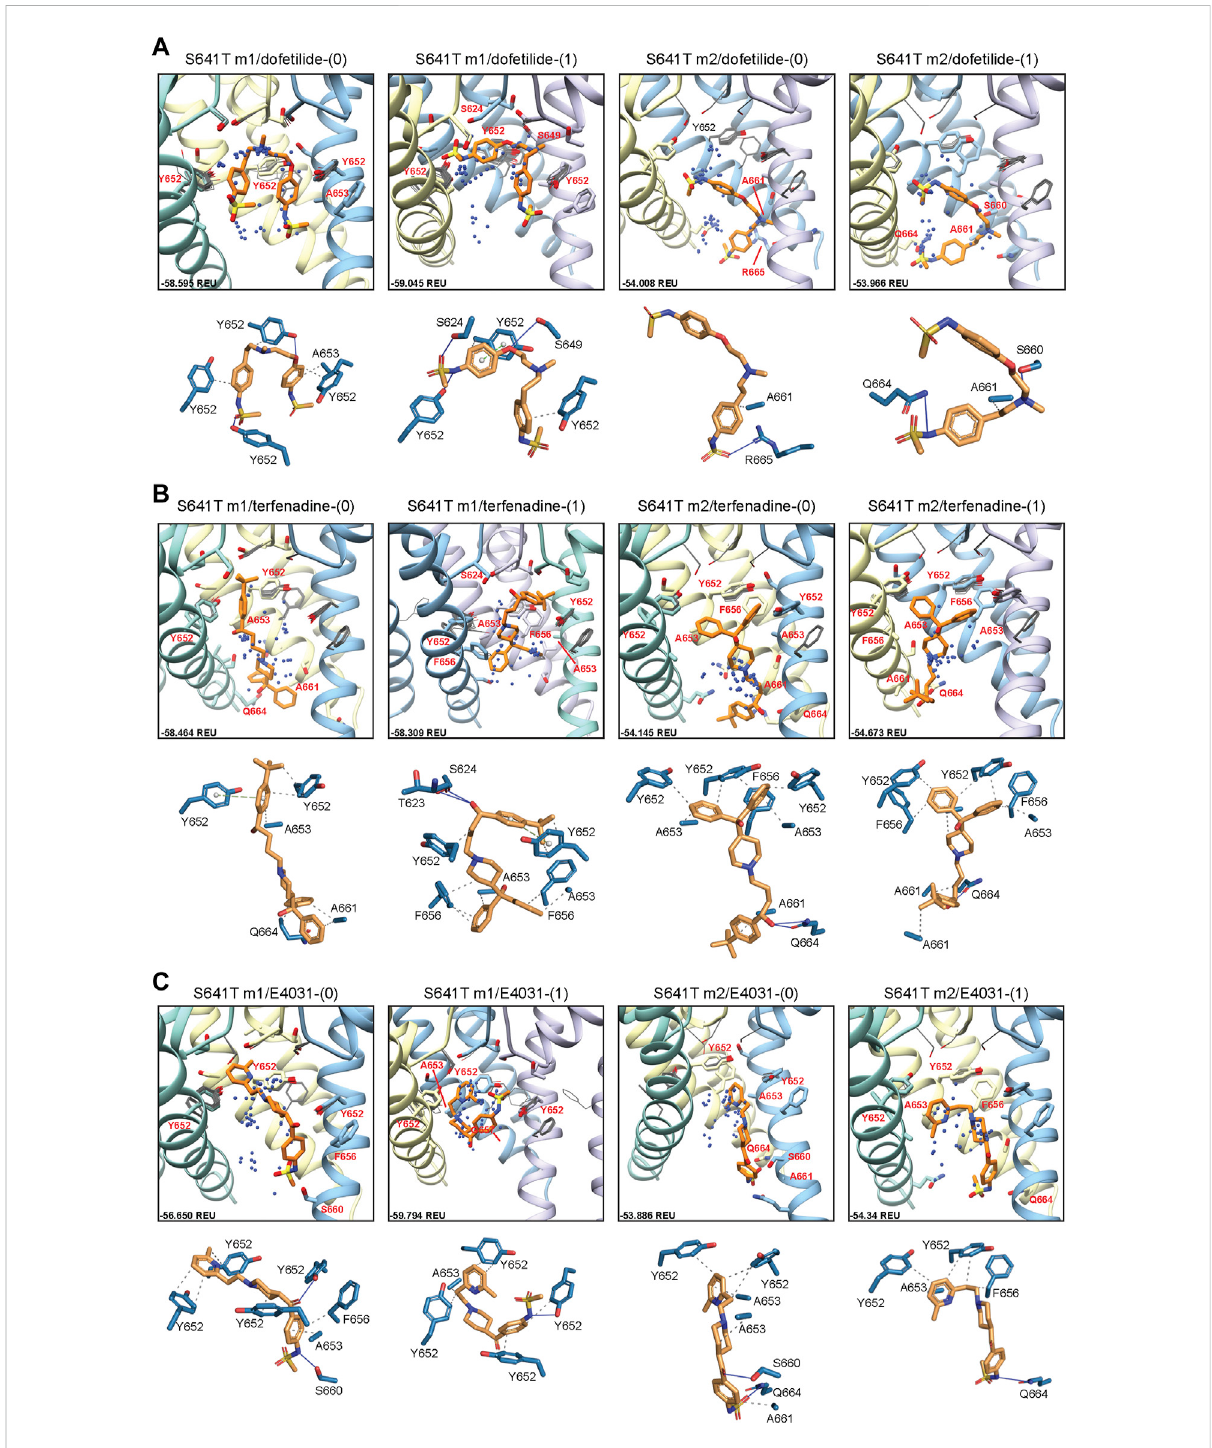
FIGURE 6 hERG S641T drug docking results for (A) dofetilide, (B) terfenadine and (C) E4031. Boxes represent top 50 scoring structures, with top-scoring structure as orange sticks (for carbon atoms) and remaining structures as blue centroids representing central nitrogen/charge group of the respective compound. Atoms, residues, and chains are shown and colored as in Figure 2. Rosetta ligand interface score for each top-scoring structure and PLIP for top-scoring poses are shown as in Figure 2 and summarized in Supplementary Table